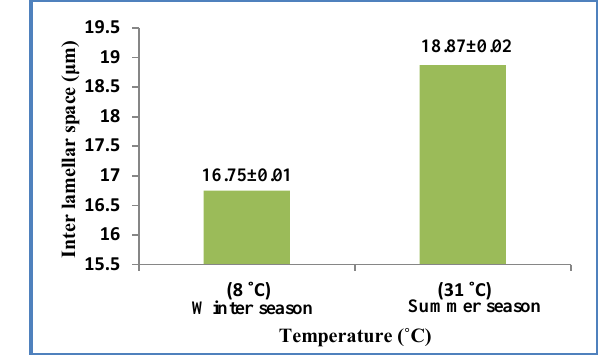
Figure, 6: Relationship between seasonal temperature and inter lamellar distance through winter and